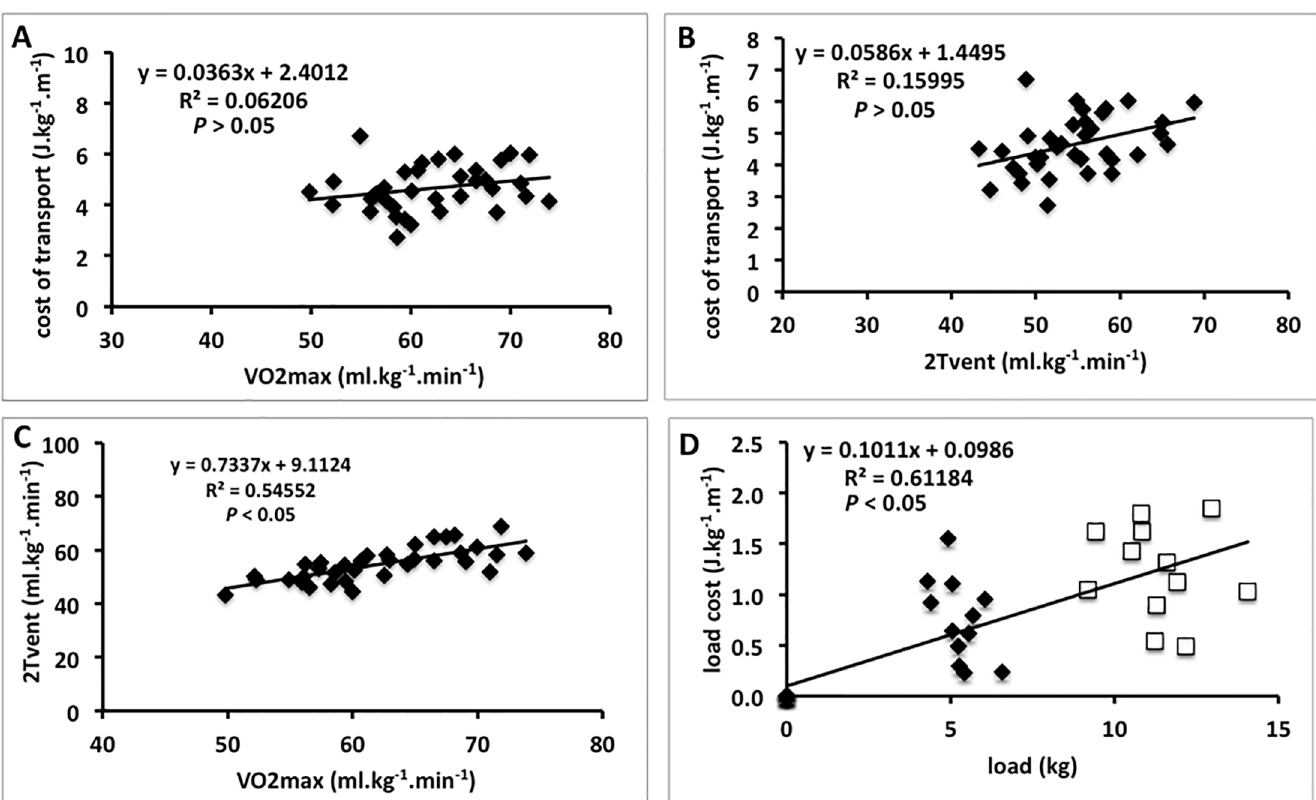
Fig 4. Scatterplot between physiological variables ( n = 12 subjects). A) The cost of transport in function of maximal oxygen consumption (VO2max) and, B) in function of second ventilatory threshold(2Tvent). C) The 2Tvent in function of VO2max. D) The metaboliccost of load (load cost = loaded − unloaded) in function of absolute load in